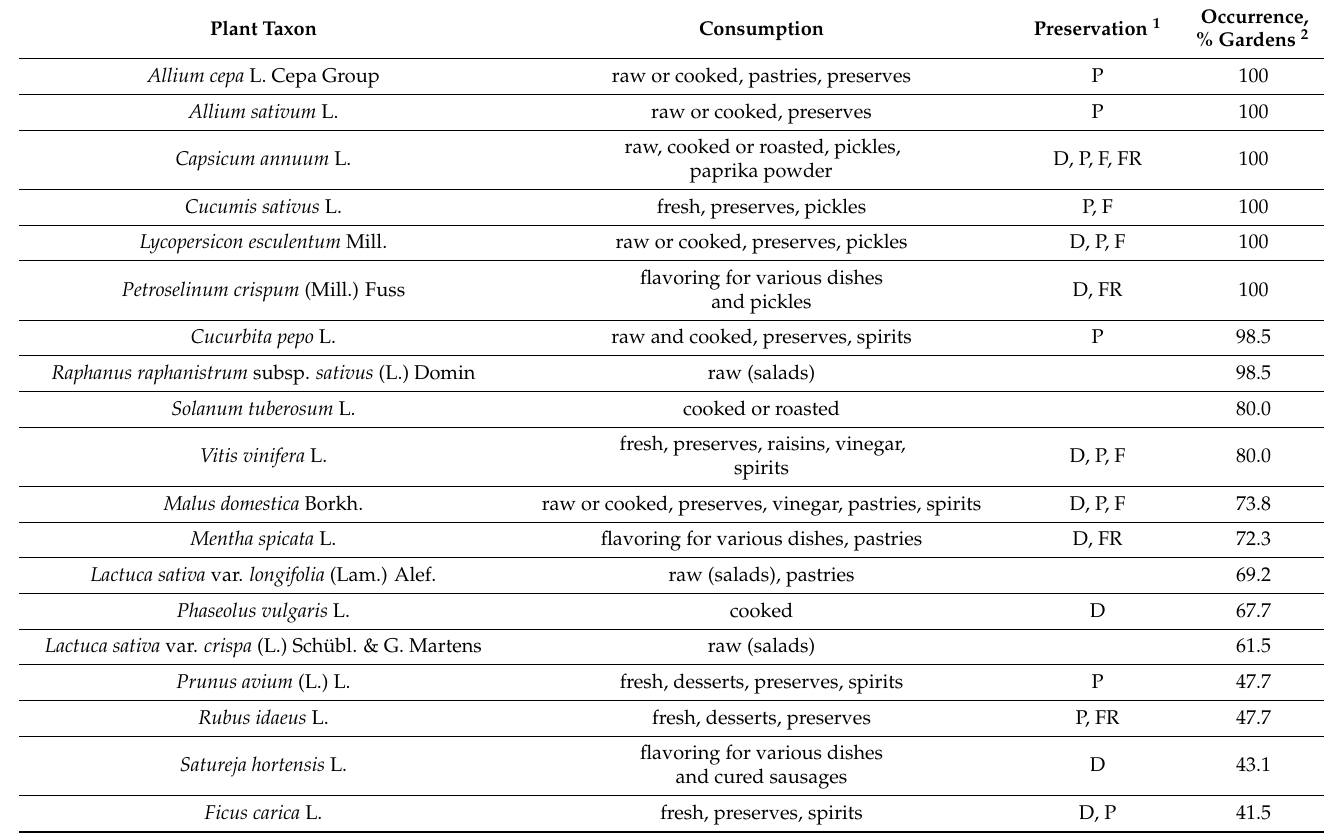
Table 3. Plant taxa cultivated in rural home gardens in all studied